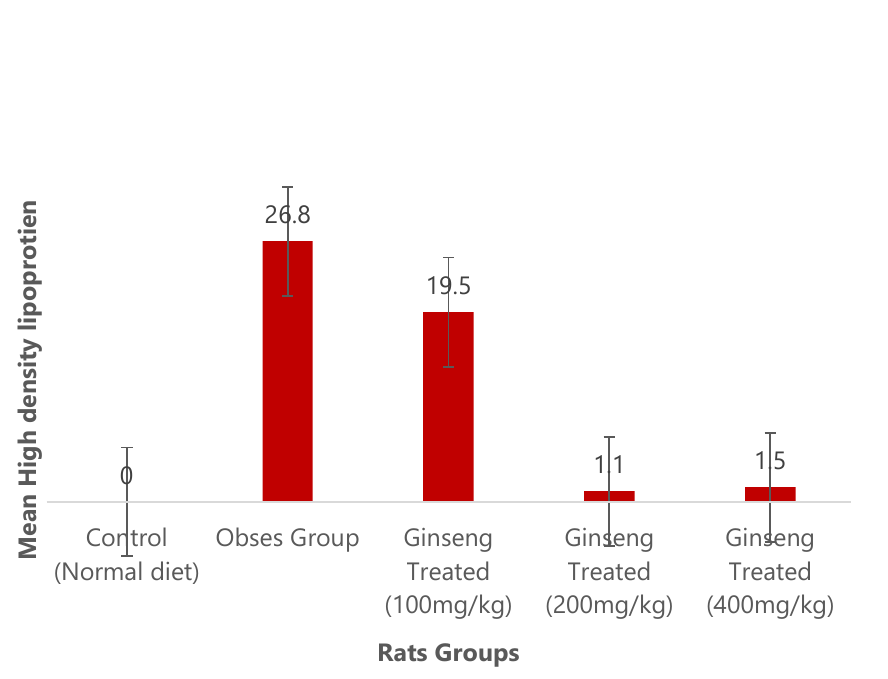
Figure 10: Comparison of mean High-density lipoprotein in different groups.